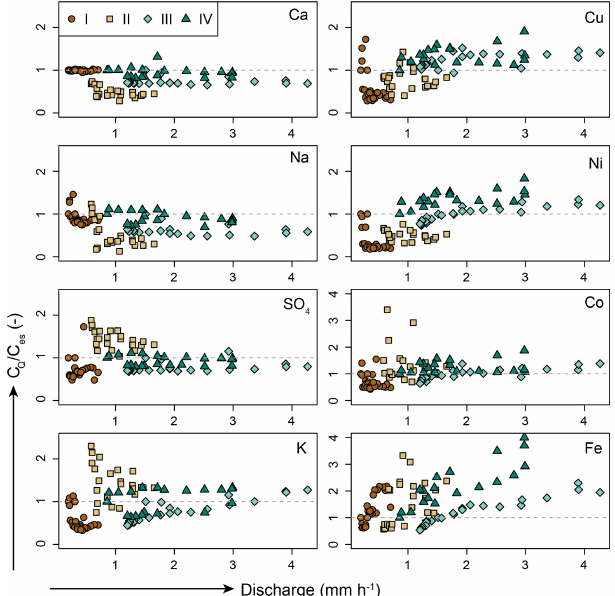
Figure 8. The ratio of the measured ( C Q ) and estimated stormflow concentrations ( C es ; Eq. 3) for calcium, sodium, sulfate, potassium, cobalt, copper, nickel and iron as a function of discharge at the catchment outlet. The broken grey line indicates where C Q and C es are equal; the different symbols reflect the different events (I–IV). Note the difference in scale for cobalt and iron. For the relationship with the simulated fraction of the catchment that was connected to the stream, see Fig.